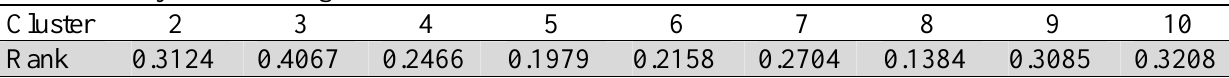
The summary of the average silhouette coefficient Cluster